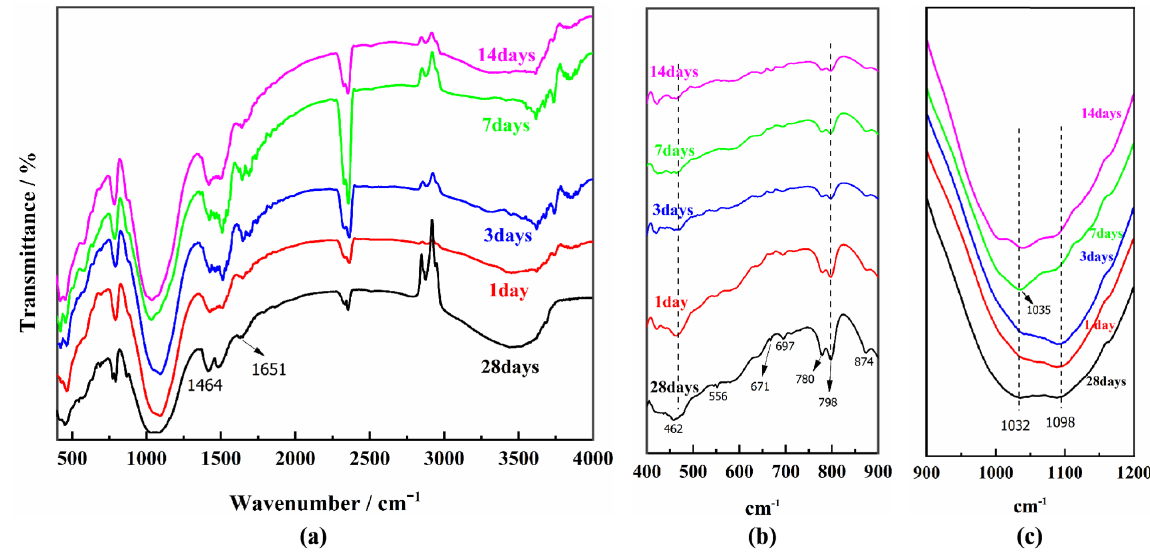
Figure 9. FTIR spectra of COSGB at different curing ages: ( a ) complete spectra; ( b ) enlargement of the 400–900 cm − 1 ; ( c ) enlargement of the 900–1200 cm − 1 .